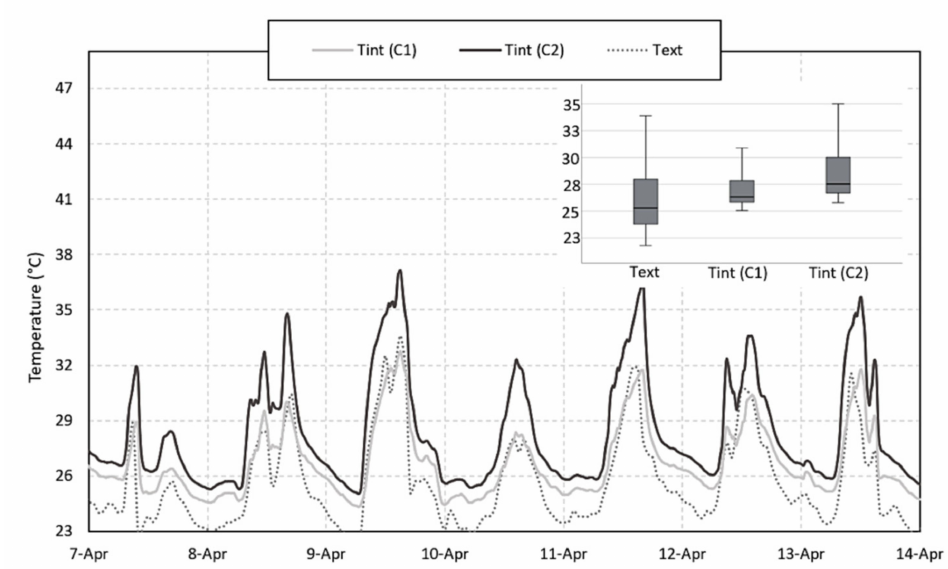
Figure 17. External and internal temperature variation in cells C1 and C2 during one week of campaign 7 (opaque envelope with reflective painting and natural ventilation by chimney effect for 24